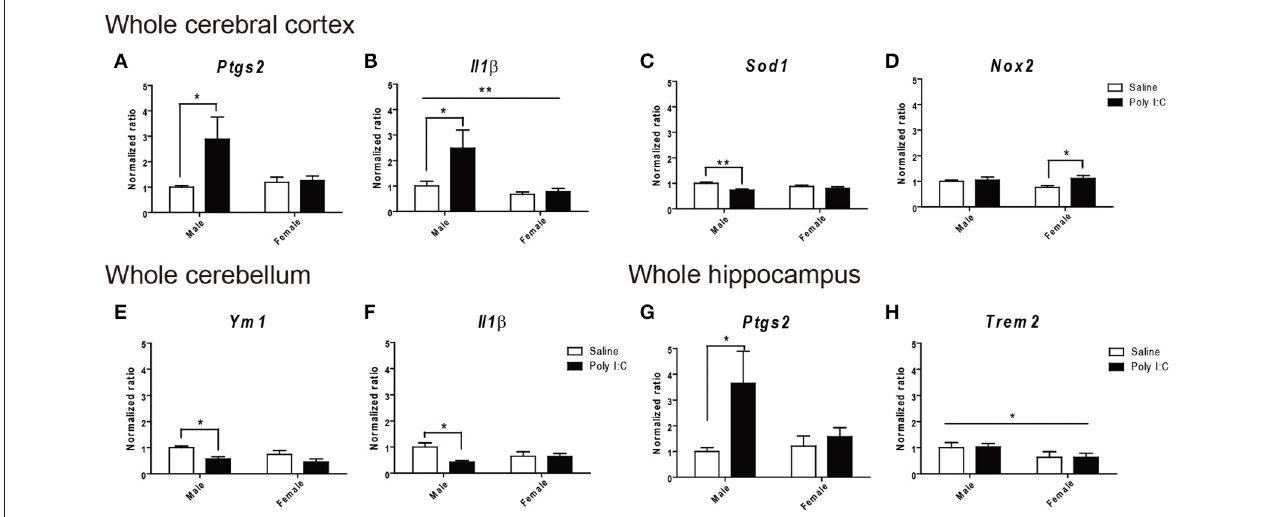
FIGURE 7 | Effects of Poly I:C on gene expression in whole cerebral cortex, cerebellum, and hippocampus. Significant changes in gene expression levels of (A–D) Ptgs2 , Il1 β , Sod2, and Nox2 were measured in the cerebral cortex, (E,F) Ym1 and Il1 β in the cerebellum, and (G–H) Ptgs2 and Trem2 in the hippocampus. n = 4–5 mice per sex and group. * p < 0.05, ** p <